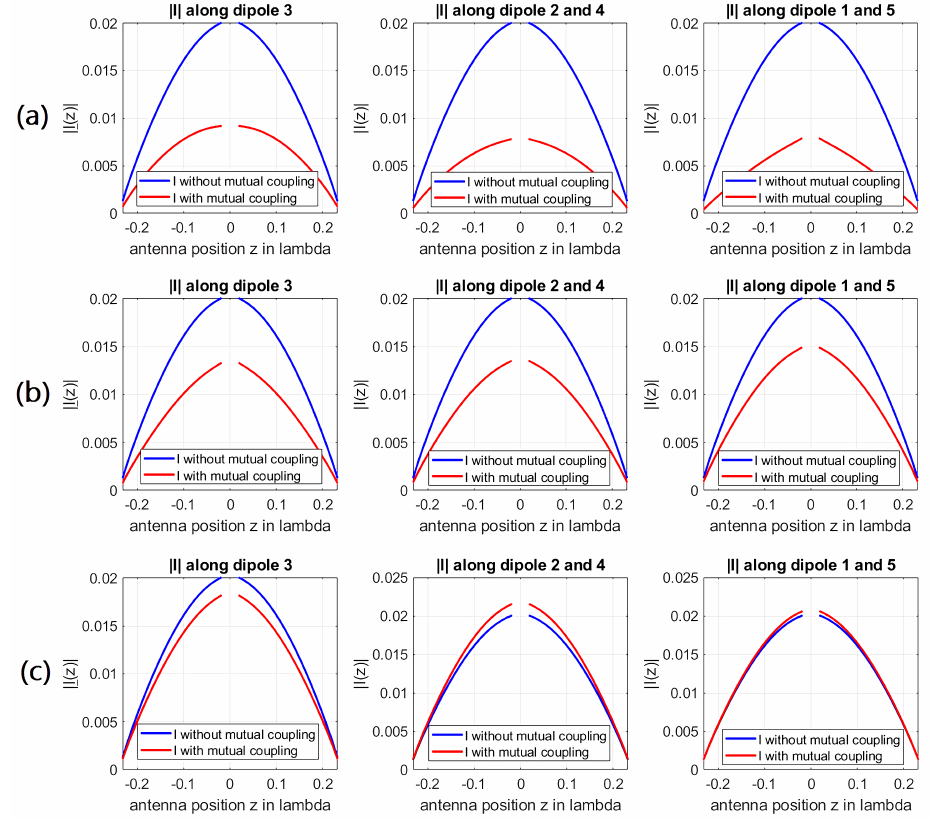
Figure 14. The current distribution along the different dipoles for the array with ( a ) 0.1 λ spacing, ( b ) 0.3 λ spacing, and ( c ) 0.5 λ spacing between each element. For the blue curve, each element has been computed separately, hence mutual coupling effects were not considered. For the red curve, the elements have been computed as an array; consequently, mutual coupling effects have been considered.